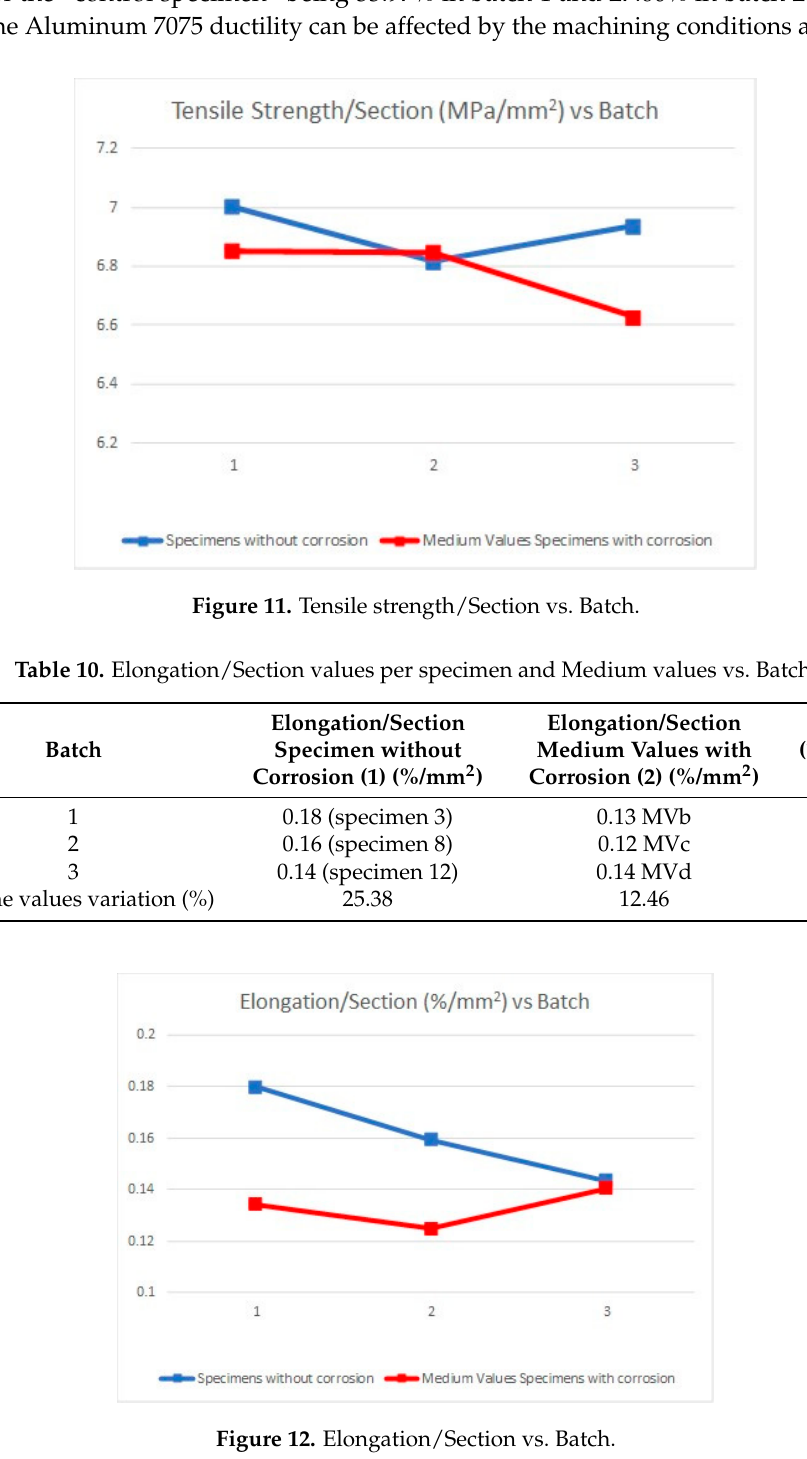
Figure 12. Elongation/Section vs. Batch.